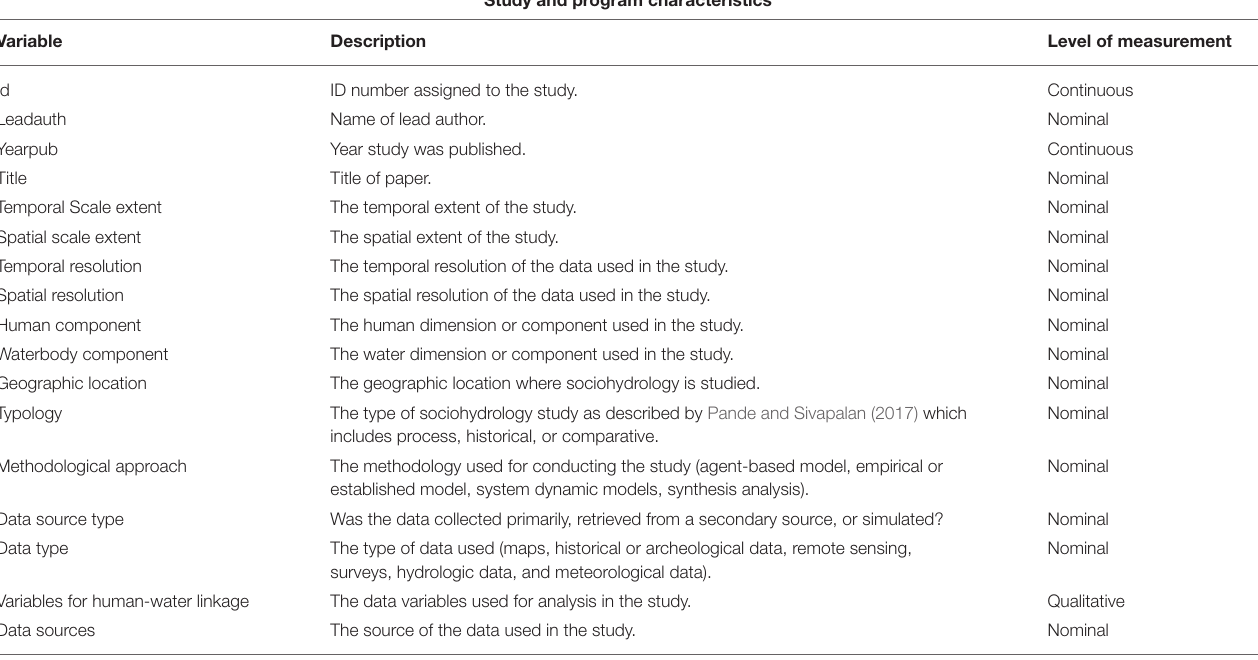
TABLE 2 | Coding schema used for each primary